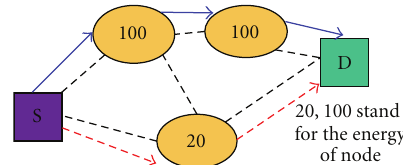
Figure 4: Route selection based on ETE metric.